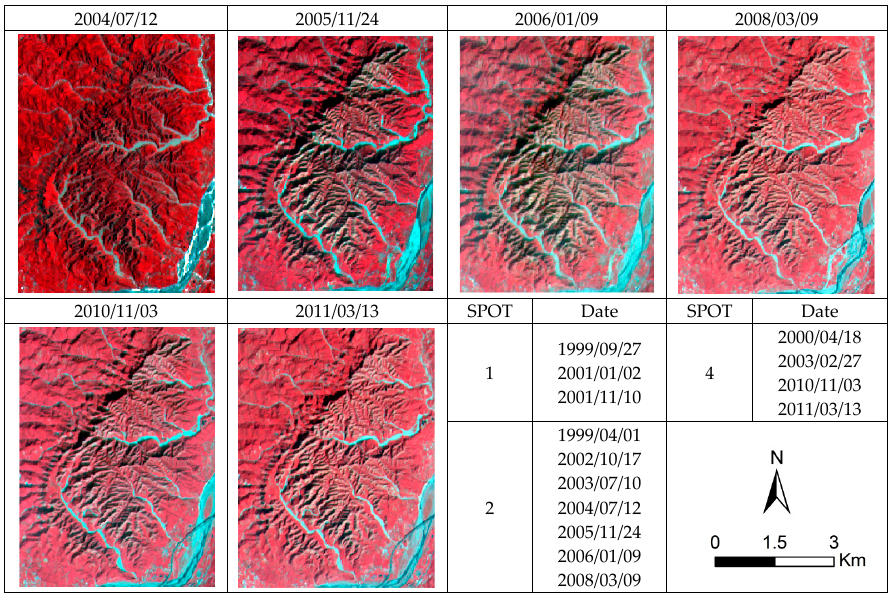
Figure 3. False color SPOT satellite images of Mt. Jou-Jou. (Image latitude and longitude coordinates: Upper Left: 24.04 ° , 120.76 ° ; Bottom Right: 23.98 ° , 120.81 ° ).